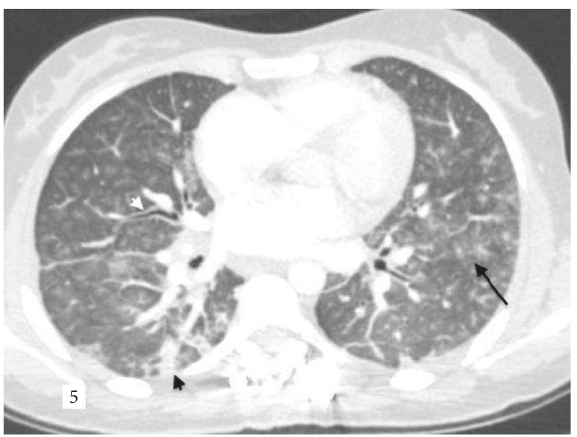
Figure 5: An 18-year-old female patient with parainfluenza (HPIV 3) pneumonia also with bone marrow transplantation due to acute lymphoblastic leukemia. According to the RSNA guidelines in “indetermine,” CORADS score given as 3. Diffuse centrilobular ground glass density nodules (black arrow), focal peripheral consolidation areas (black arrowhead), and increased peribronchial wall thickness (white arrowhead) are observed.